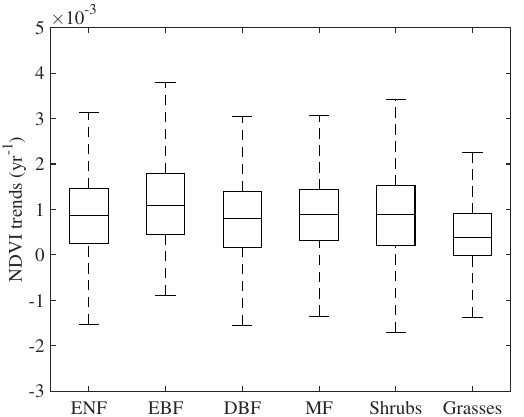
Figure 7. Box plot for the trends of growing season NDVI of Evergreen Needle Forest (ENF), Evergreen Broadleaf Forest (EBF), Deciduous Broadleaf Forest (DBF), Mixed Forest (MF), Shrubs and Grasses from 1982 to 2011. The edges of the boxes are 25th and 75th percentiles [54].